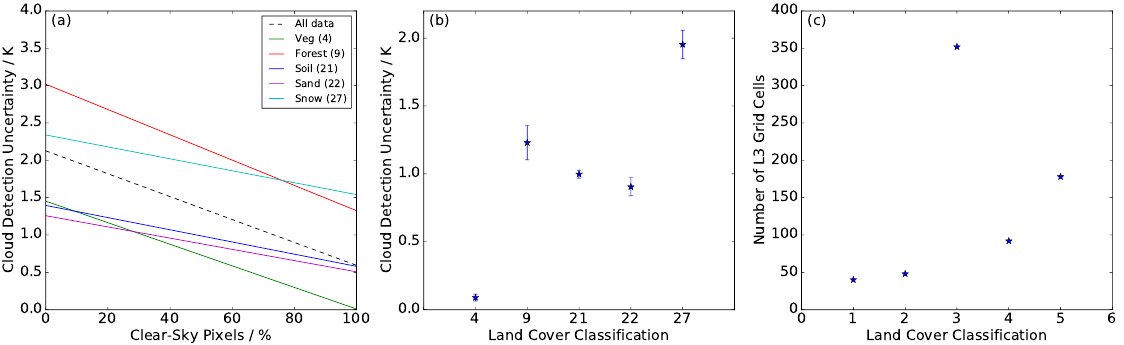
Figure 10. Biome-specific linear regression models for cloud detection uncertainty dependence on clear-sky fraction ( a ). Standardised cloud detection uncertainties as a function of land cover classification ( b ). Panel ( c ) shows the number of observations for each land cover classification, with land cover classifications defined in Table